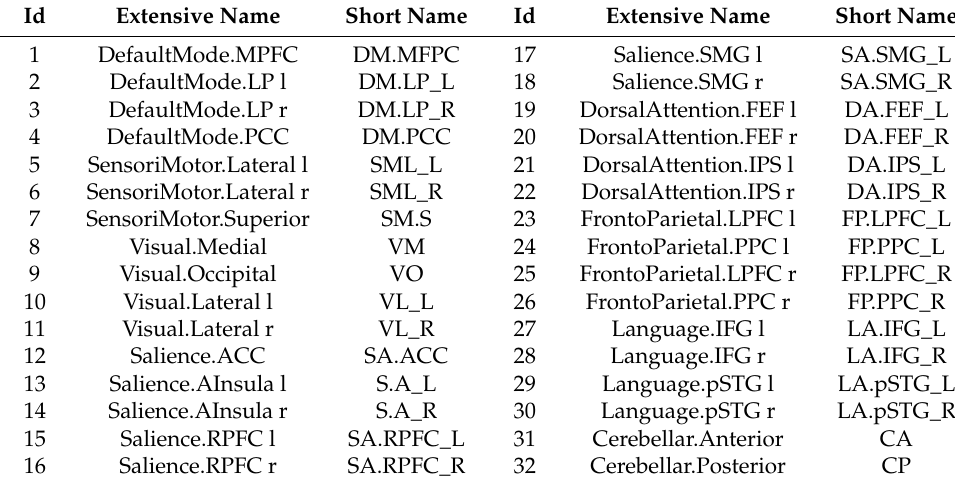
Figure 2. 3D color brain map depicting resting-state functional magnetic resonance imaging (fMRI) functional regions. In each region, resting-state networks (RSNs) are subdivided on the basis of their different functions, such as the default mode network (DMN), the sensorimotor network, the auditory network, the visual network, the executive control network, the lateralized frontoparietal network, and the temporoparietal network. Table 1. Brain resting-state networks (RSNs) nomenclature.